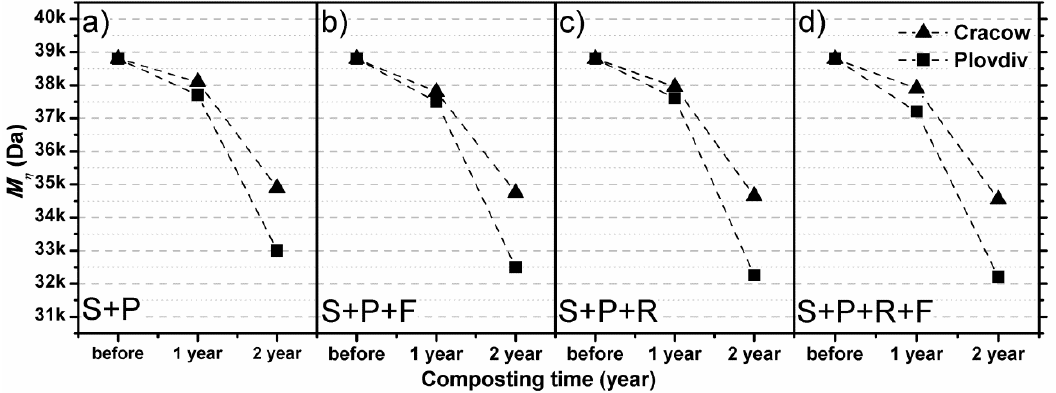
Figure 2. The changes in viscosity-average molecular weight of PLA during composting in: ( a ) soil with peat, ( b ) soil with peat covered with foil, ( c ) soil with peat and Radivit ® , and ( d ) soil with peat and Radivit ® covered with foil.